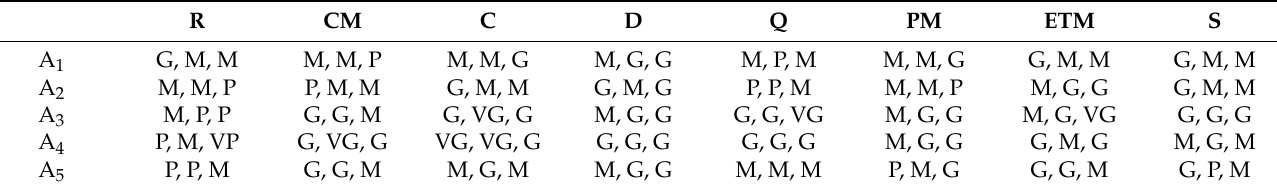
Table 6. Initial evaluation scores given by the three